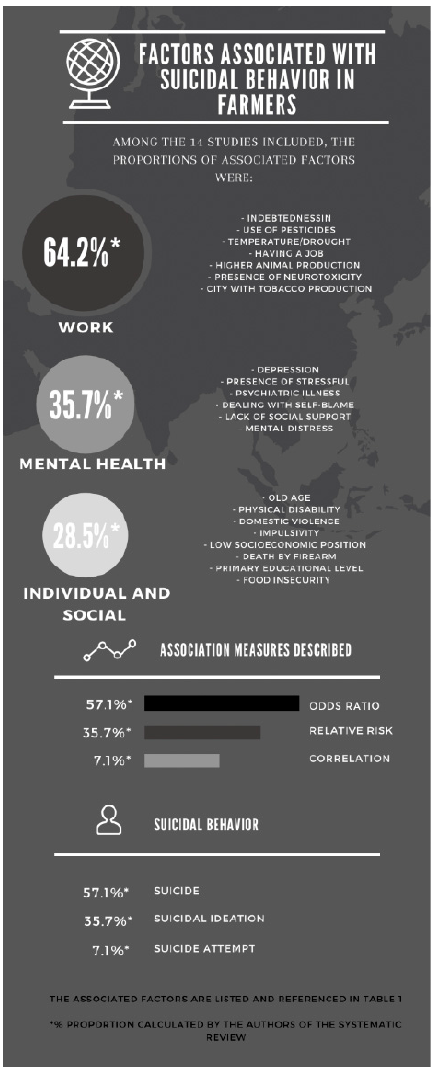
Figure 5. Factors associated with suicidal behavior in farmers. (App used: Canva Pty Ltd. [42]).